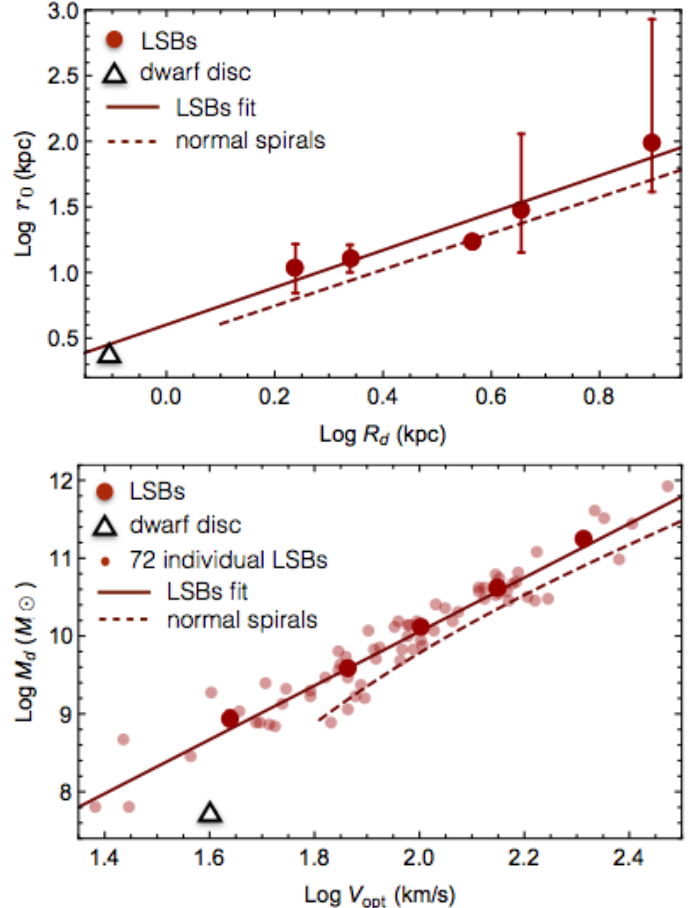
Figure 12. ( up ): DM halo core radius vs. stellar disc scale length: data from the 5 coadded LSB RCs (points with errorbars) and their best fit (solid line) alongside with the same best fit in spirals (dashed line) and dwarf disks (triangle) [30,167]). ( bottom ): stellar disc mass vs. the optical velocity. Legend as in the upper plot, also shown the individual data for the 72 LSBs of the sample (small circles). The spiral’s best fit has a statistical uncertainty of 0.1 dex. Image reproduced from [38].